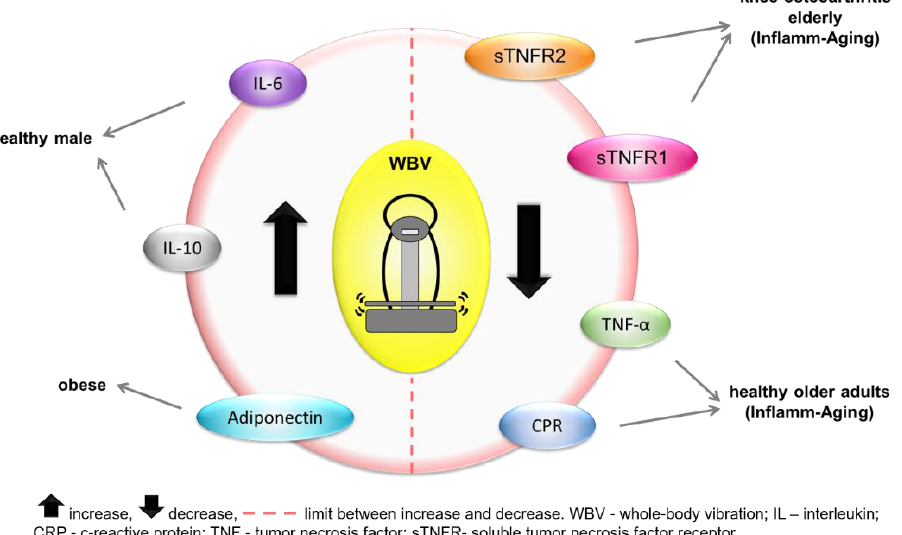
Figure 3. Inflammatory biomarker responses to whole-body vibration intervention in each clinical status.